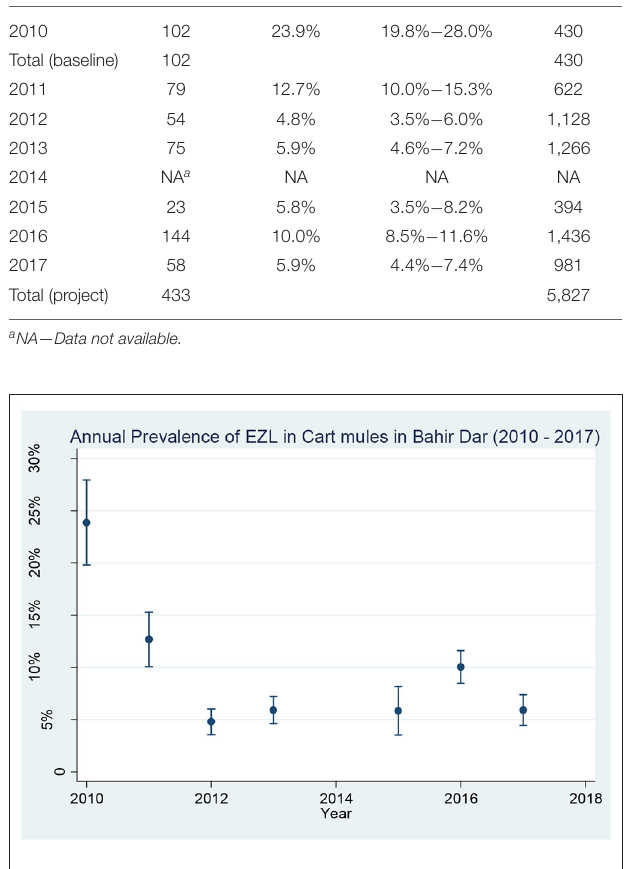
FIGURE 3 | Annual prevalence of EZL in cart mules in Bahir Dar from 2010 to 2017 [NB: Error bars represent 95% confidence interval around EZL prevalence value].